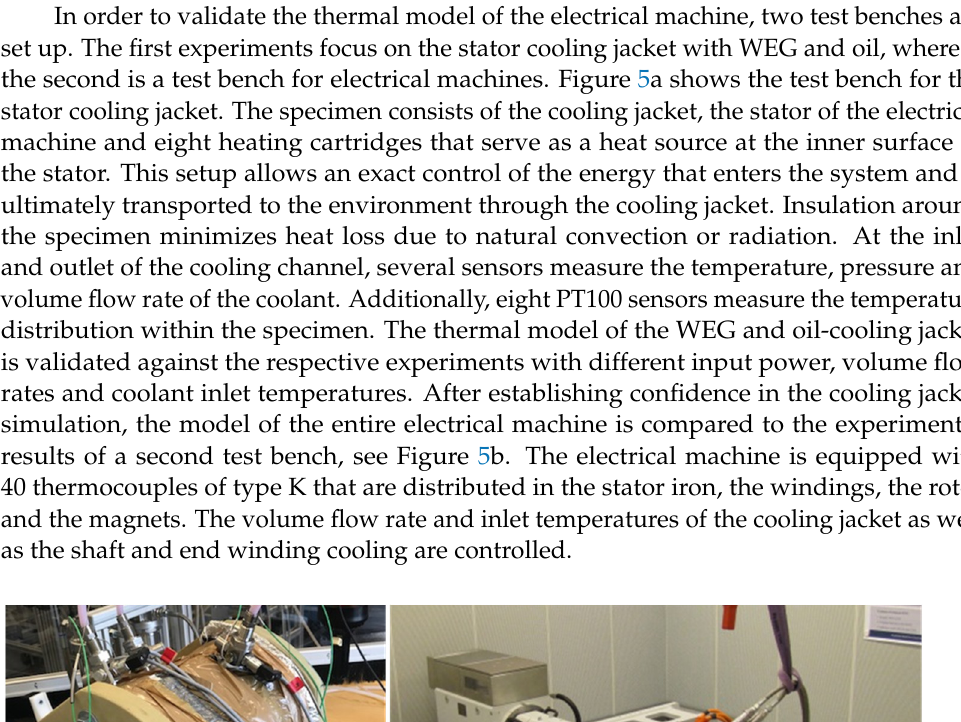
Figure 6. Validation of the thermal model with test bench data: ( a ) comparison of simulated heat flows for different volume flow rates for the WEG and oil-cooling jacket with results of the cooling jacket test bench and ( b ) comparison of simulated continuous torques for the water-cooling jacket and the rotor cooling jacket with results of the electric machine test bench. In order to validate the resulting model, the continuous power is determined by in- creasing the torque for various speeds until the temperature limit of the machine is r e l a t i v e h e a t fl o w Q